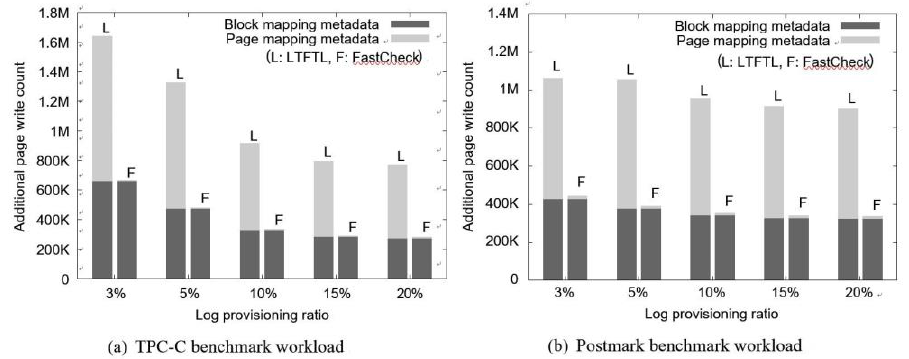
Figure 7. Overhead cost during a normal execution period.